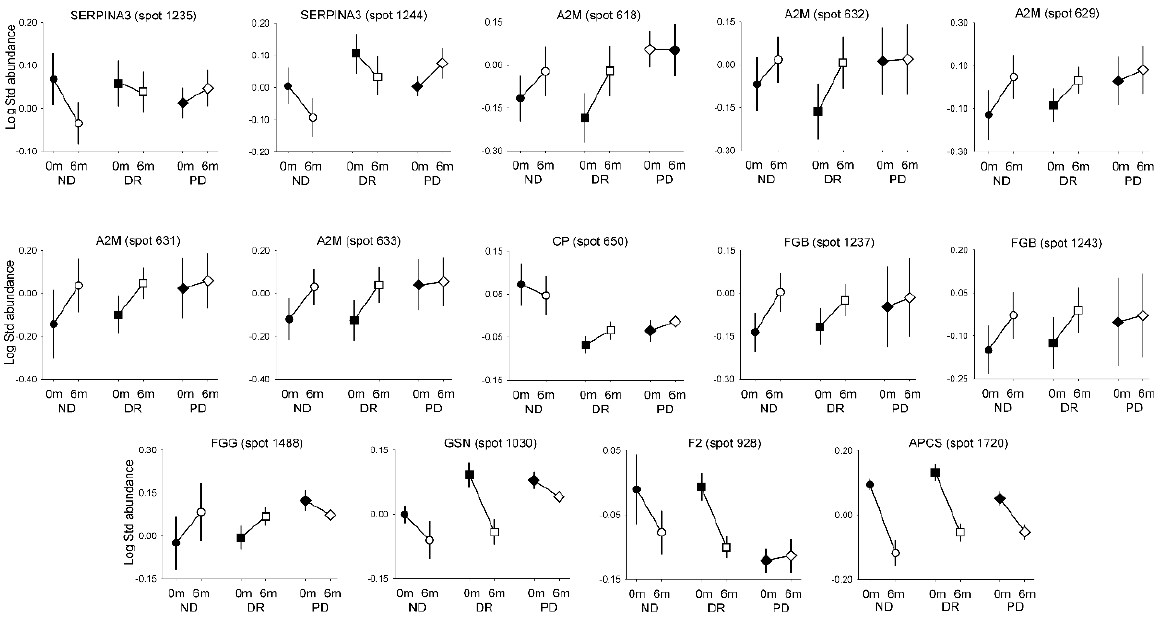
Figure 2 . Interactions between changes in protein abundance before and after bariatric surgery, and groups classified by diabetes and its remission or persistence. ND, non-diabetic patients; DR, diabetes remission; PD, persistent diabetes. Data are means ± SEM.